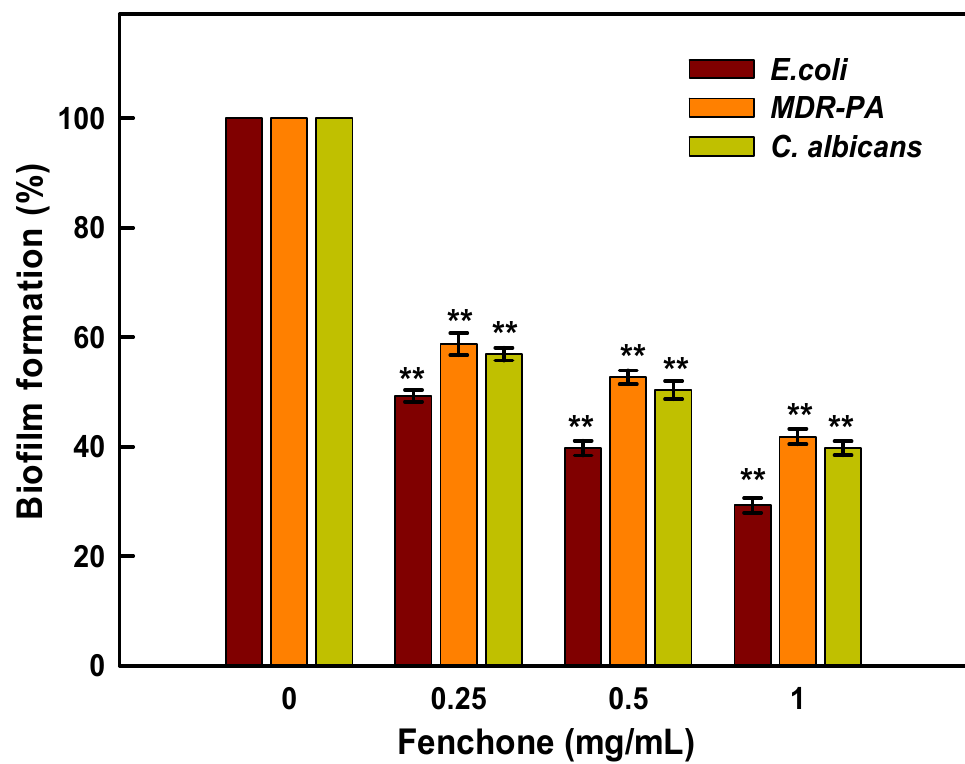
Figure 8. Impaired biofilm formation of E. coli , MDR-PA, and C. albicans caused by fenchone treatment. The data is presented as average of three independent tests in triplicates with standard deviation. The asterisks (**) represent the significance as p < 0.001 against their control experiments by One-Way ANOVA-based Pairwise Multiple Comparison Procedures (Holm-Sidak method), whereas overall significance level = 0.05 was conductedon SigmaPlot 11.05 statistical analysis software.